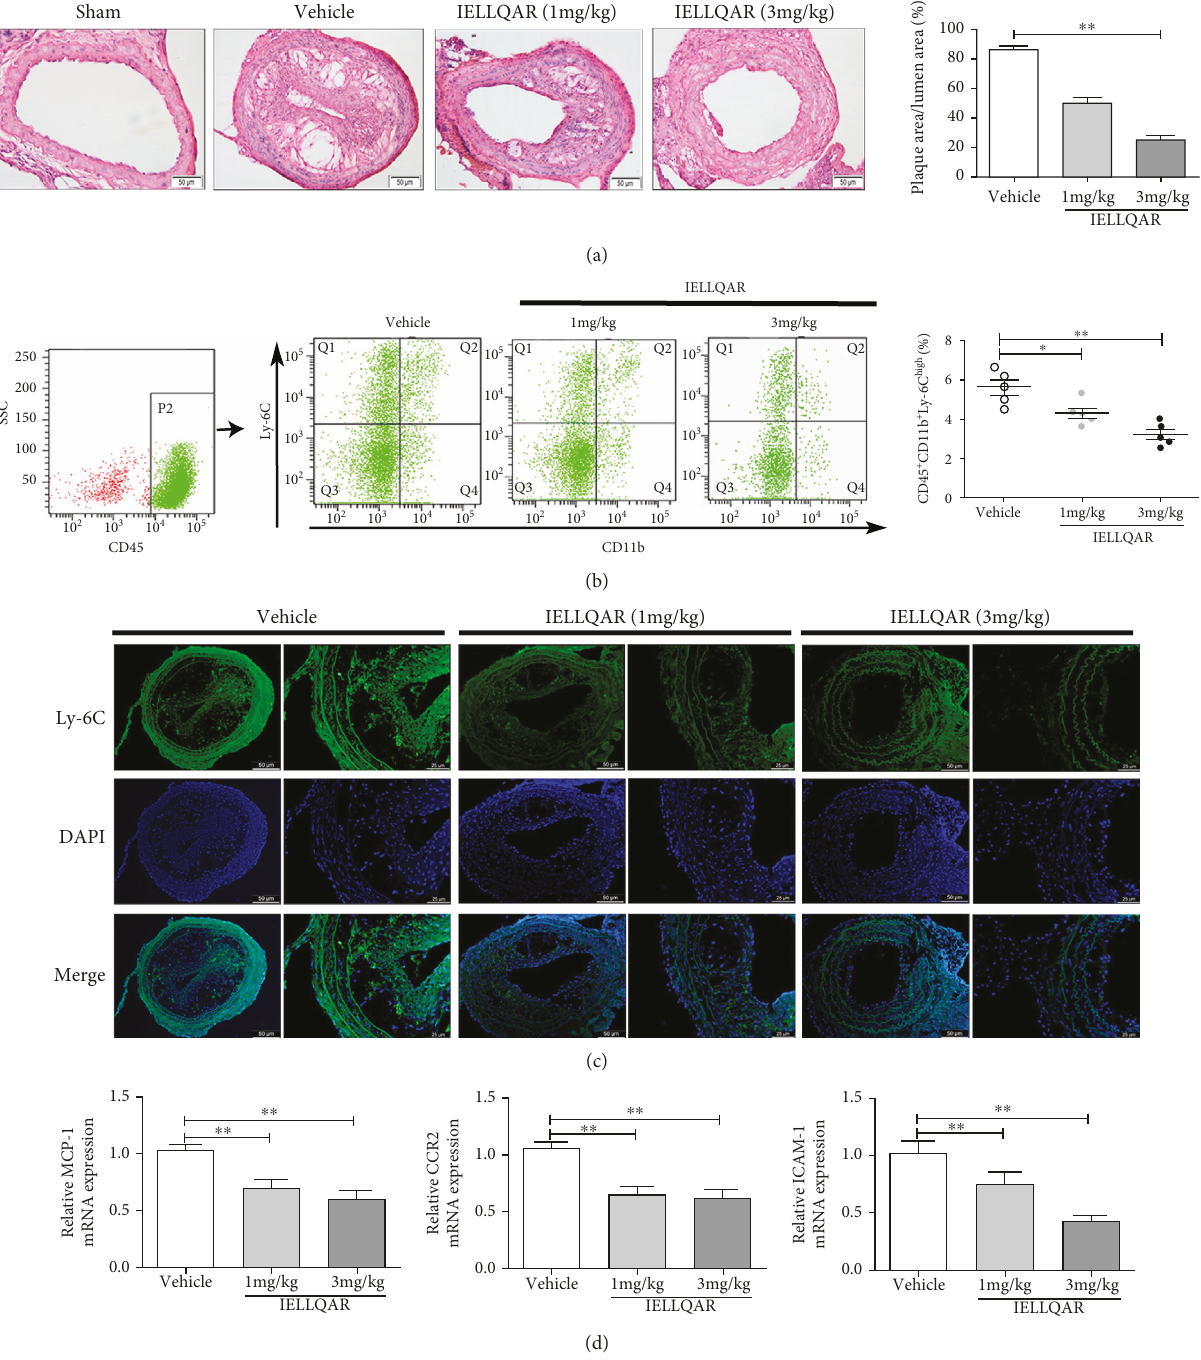
Figure 5: IELLQAR decreases PLCA-induced atherosclerosis and impaired Ly-6C high monocyte recruitment to the arterial walls of ApoE -/- mice. Eight-week-old male ApoE-de fi cient mice randomized into four treatment groups, sham group, normal saline (NS), and two IELLQAR treatment groups (1 and 3 mg/kg), and fed a normal chow diet for 4 weeks. In PLCA surgery, three (left external carotid, internal carotid, and occipital artery) of the four branches of ApoE -/- mice were ligated, and only the superior thyroid artery was left to provide blood circulation. (a) Representative histological analysis results of the carotid artery following H&E staining ( n ≥ 5 ). Scale bar: 50 μ m. (b) Flow cytometric dot plots showing the percentage of CD45 + CD11b + Ly-6C high monocytes in circulation. (c) Representative histological analysis results of the carotid artery following immuno fl uorescence staining with Ly-6C ( n ≥ 5 ). Scale bar: 50 μ m and 25 μ m, respectively. (d) The mRNA expression levels of MCP-1, CCR2, and ICAM-1 in carotid artery tissue were measured by qRT-PCR ( n ≥ 5 ). Data are presented as the mean ± SEM ; ∗ p < 0 05 , ∗∗ p < 0 01 , and ∗∗∗ p < 0 001